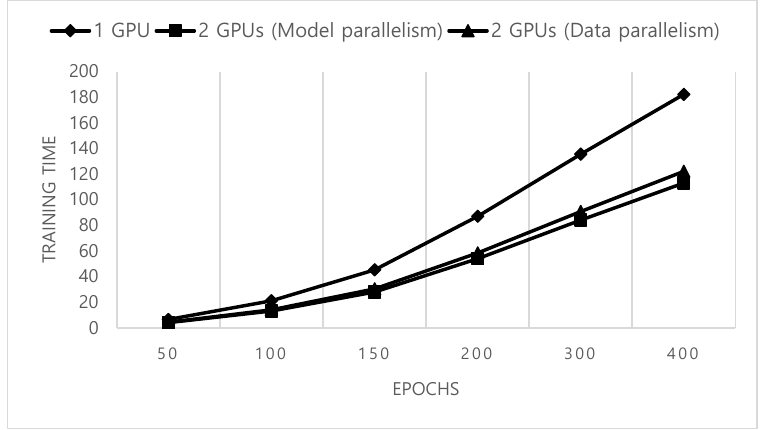
Figure 6. Training time difference for